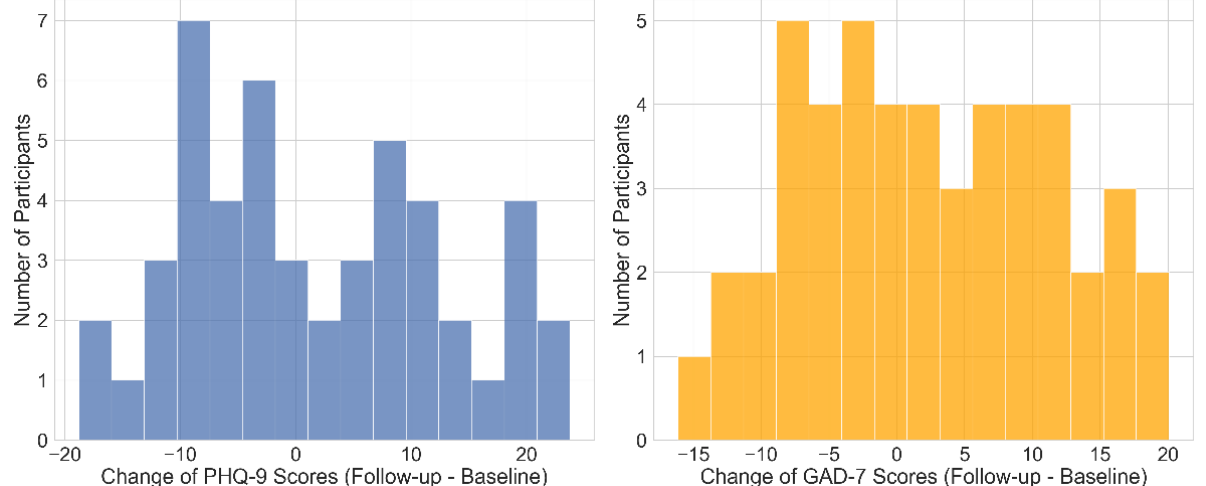
Figure 5. The distributions of the changes in PHQ-9 depression and GAD-7 anxiety scores before and after the lockdown. The PHQ-9 scores are shown on the left, and the GAD-7 scores are shown on the right. GAD-7: General Anxiety Disorder-7; PHQ-9: Patient Health Questionnaire-9.